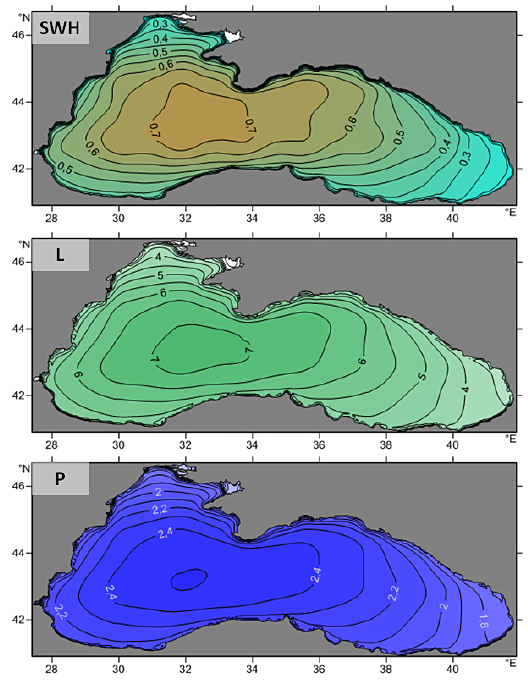
Figure 6. Maps of calculated average significant wave height [m], wave length [m] and period [s] in spring.